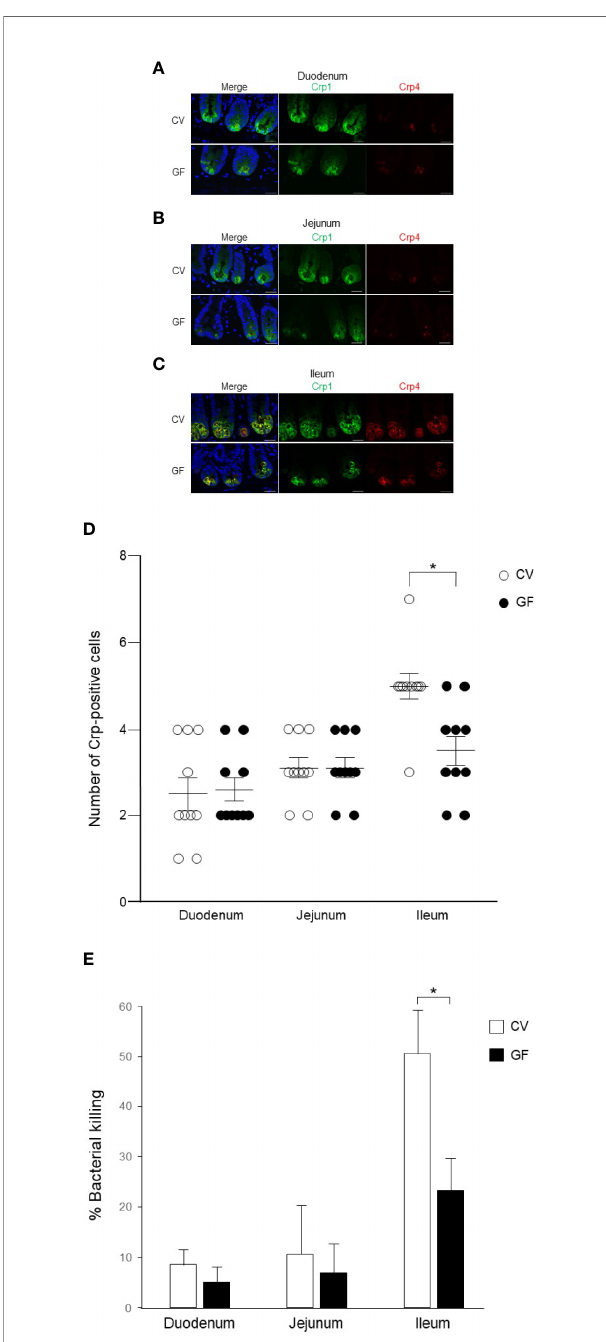
FIGURE 4 | Cryptdin expression and Paneth cell number in the small intestine and bactericidal activities of Paneth cell secretions of conventional and germ-free mice. Representative immuno fl uorescent staining images for Crp1 (green) and Crp4 (red) in the duodenum (A) , the jejunum (B) , and the ileum (C) of conventional (CV) and germ-free (GF) mice staining together with 4 ’ ,6-diamidino-2-phenylindole (DAPI) (blue). Scale bars indicate 20 m m. Number of Crp-positive Paneth cells in single crypt of duodenum, jejunum, and ileum in CV and GF mice (D) . n = 10 for each, mean ± SD, *p < 0.05. Percentage of bacterial killing of Paneth cell secretions in ex vivo bacterial infection assay in CV and GF mice. n = 3 each, mean ± SD, *p < 0.05 (E)